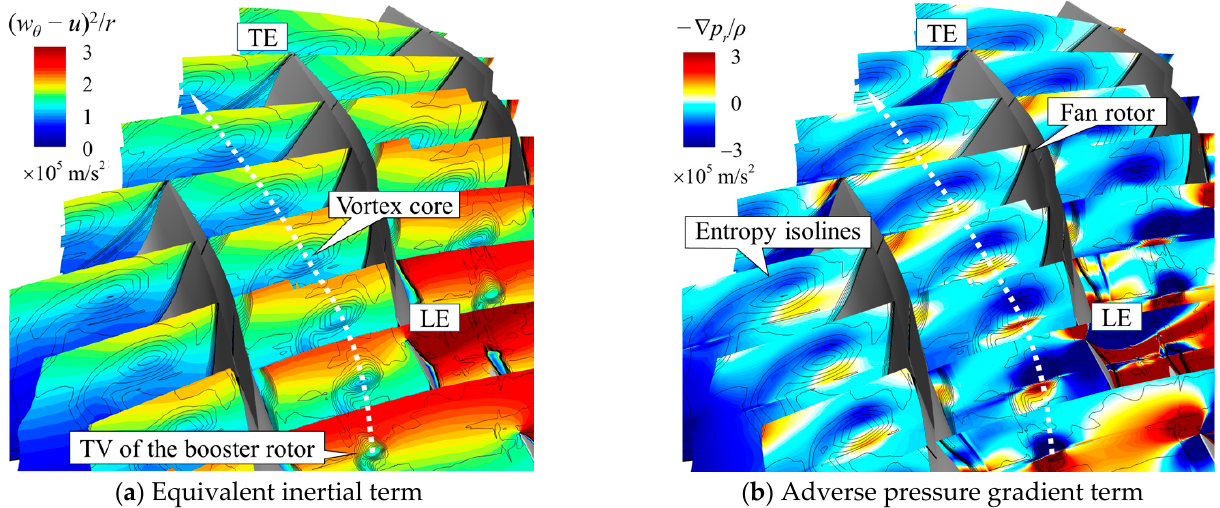
Figure 22. Streamwise distribution of the equivalent inertial force and adverse pressure gradient at N1.